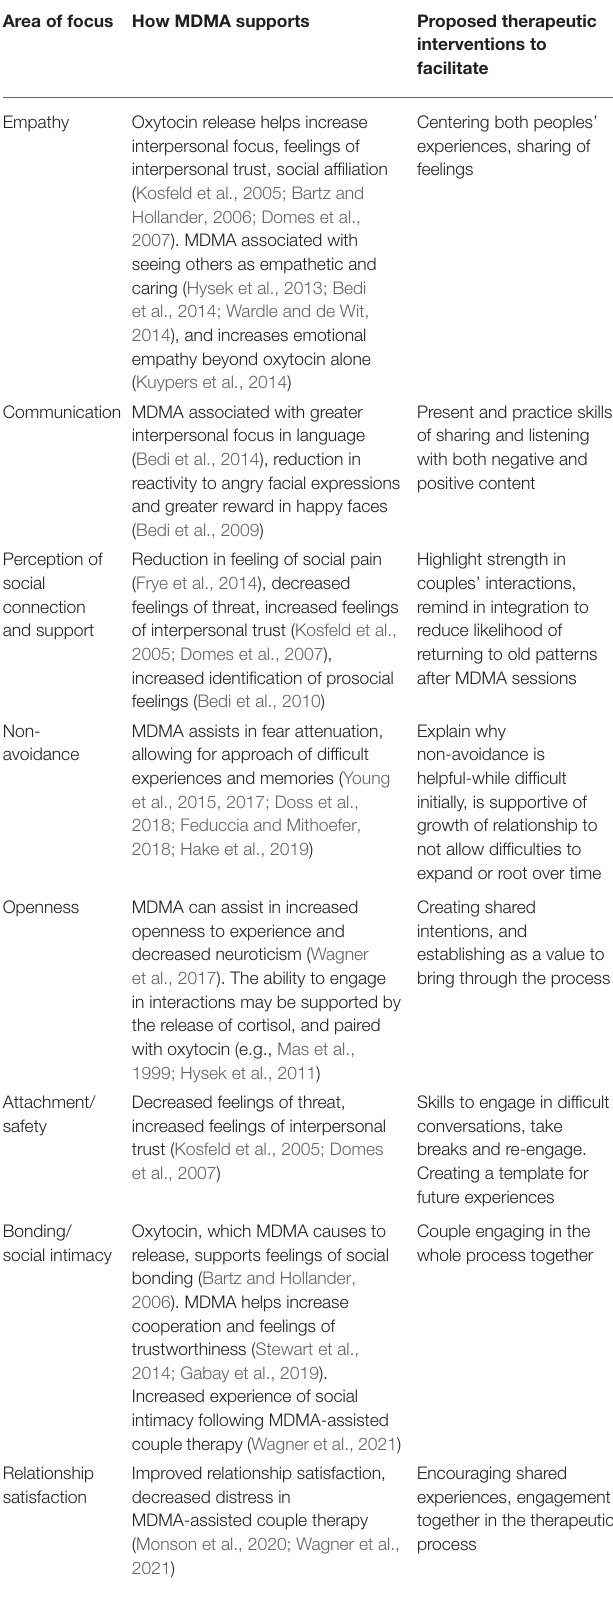
TABLE 1 | Areas of focus for MDMA-assisted couple therapy